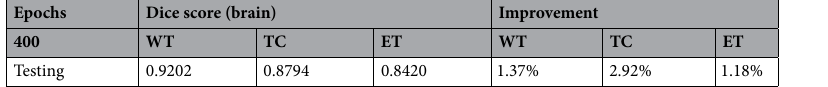
Epochs Dice score (brain) Improvement Table 7. The Dice scores of the WT, TC, and ET in brains with postprocessing and the corresponding improvement percentages.